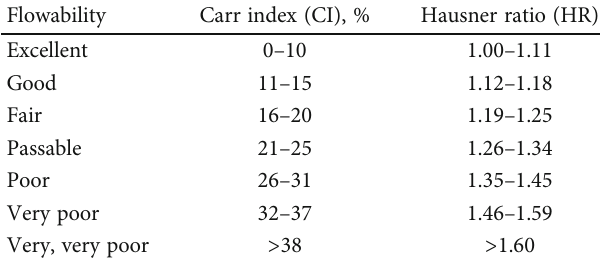
Table 2: Flowability classi fi